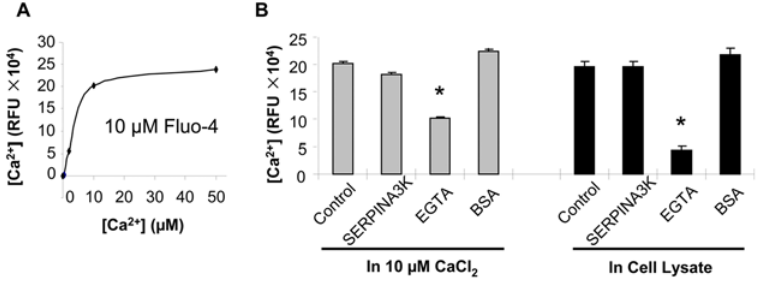
Figure 5. SERPINA3K does not chelate free calcium. Free [Ca 2 + ] was measured by the fluorescence of the Fluo-4 (pentapotassium salt). ( A ) A Ca 2 + /Fluo-4 binding curve was plotted with different concentrations of CaCl 2 and 10 m M Fluo-4. ( B ) SERPINA3K (10 m M) was incubated with 10 m M CaCl 2 or a cell lysate in the presence of 10 m M Fluo-4. EGTA (10 m M) and BSA (10 m M) were used as positive and negative controls, respectively. Free [Ca 2 + ] was measured (mean 6 SEM, n=3). * P , 0.01, versus control